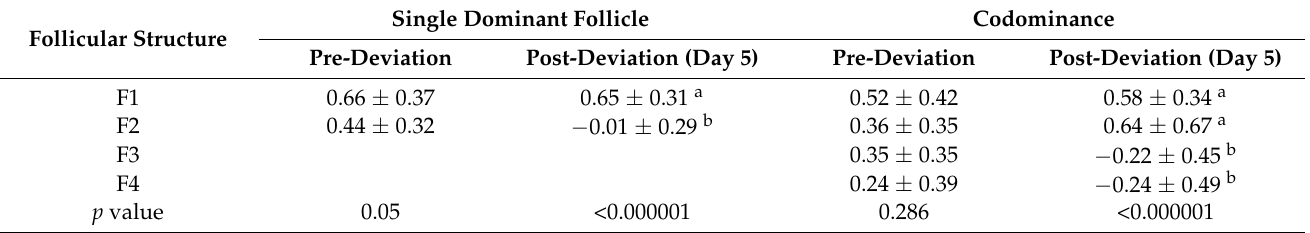
Table 3. Follicular growth rates in llamas ( Lama glama ): single DF vs. codominance deviation.